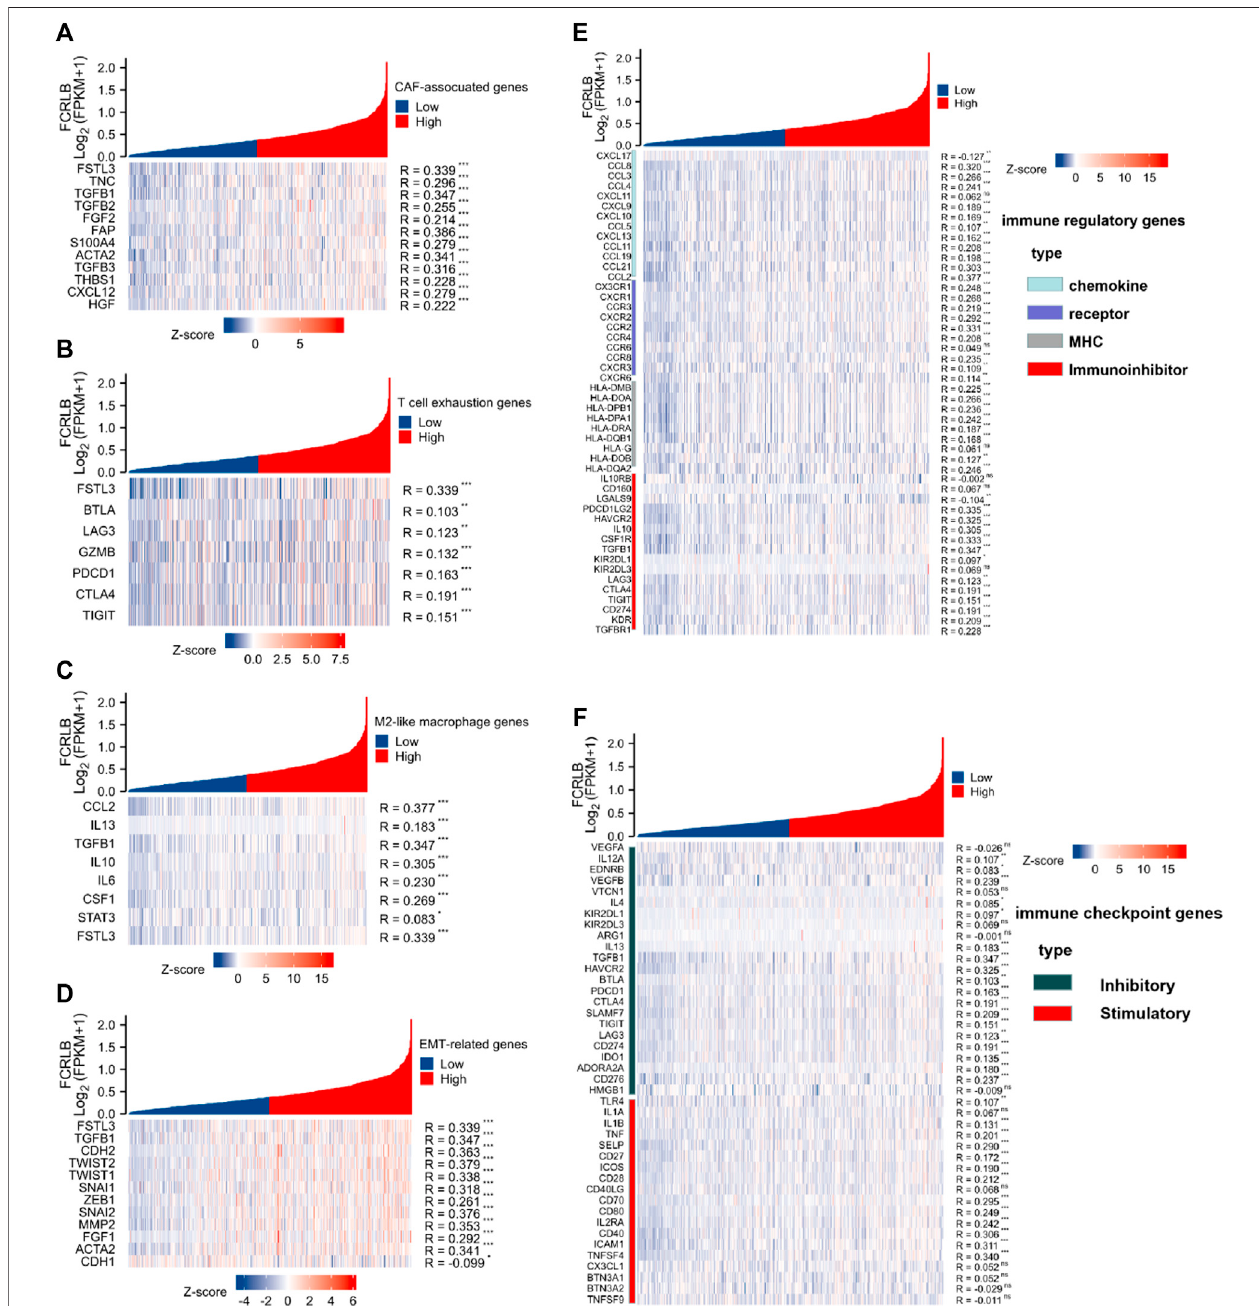
FIGURE10| TherelationshipofFCRLBexpressiontoimmune-relatedmodulatorsandimmunecheckpointmoleculesintheTCGACRCcohort. (A – D) FCRLBwas signi fi cantly positively correlated with most CAF-related genes (A) , T cell exhaustion genes (B) , M2 like macrophage genes (C) , EMT-related genes (D) . (E) FCRLB expression level was signi fi cantly correlated with majority of the immune regulatory genes. (F) FCRLB expression level is notably correlated with the expression of immune checkpoint molecules in CRC. * p < 0.05, ** p < 0.01, *** p < 0.001, ns: no signi fi cant